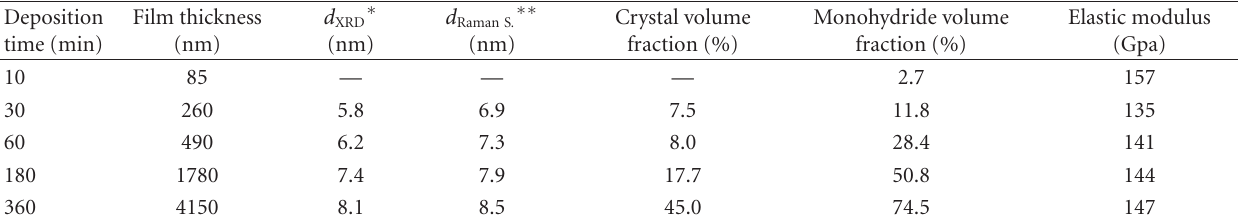
∗ d XRD : crystal size measured by XRD. ∗∗ d Raman S . : crystal size measured by Raman